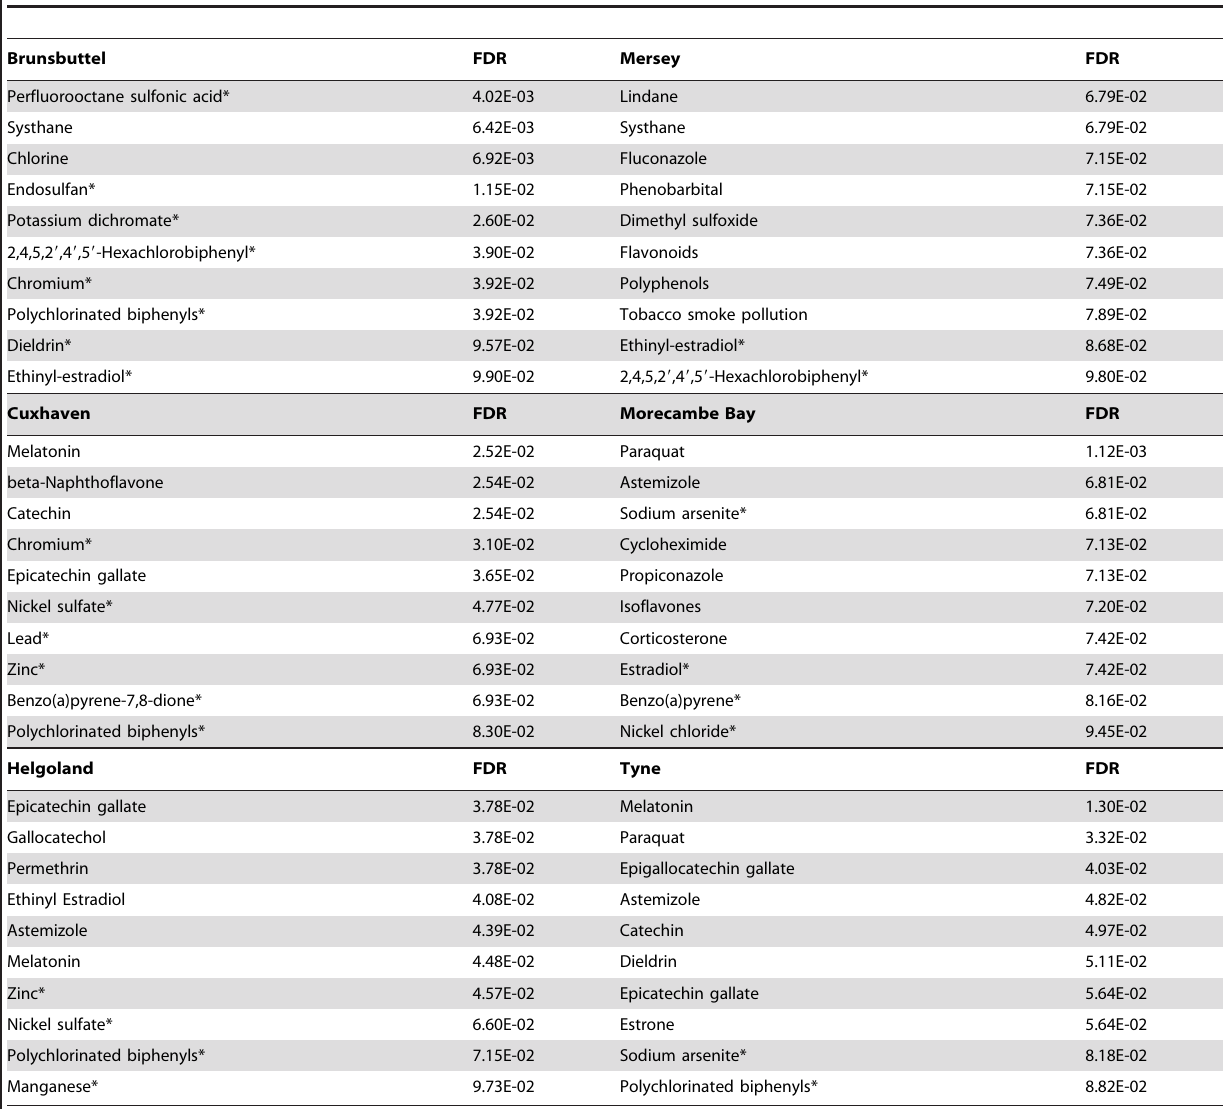
Table 2. Environmental contaminants predicted from